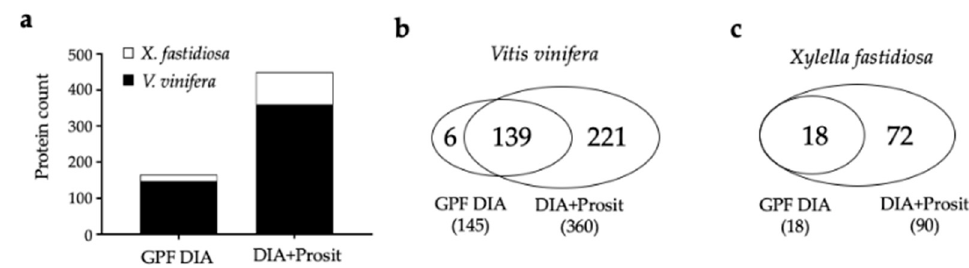
Figure 2. Vascular leaf sap proteomic analysis of Vitis vinifera and Xylella fastidiosa : ( a ) total proteins identified by data-independent acquisition (GPF DIA) and DIA + Prosit; ( b ) Venn diagram of the number of proteins identified by each method for V. vinifera ; and ( c ) for X. fastidiosa .